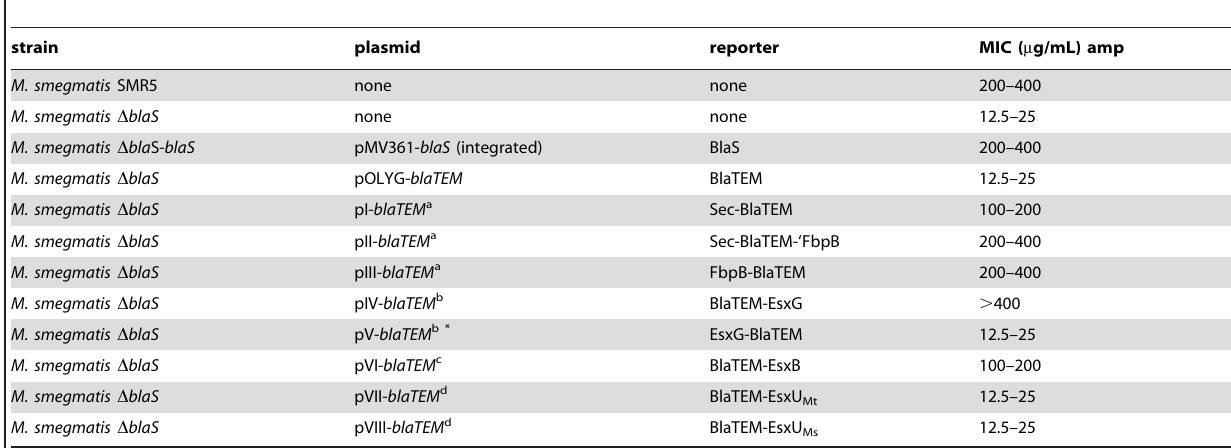
Table 1. Ampicillin MIC of M. smegmatis D blaS strains with or without reporter plasmid.